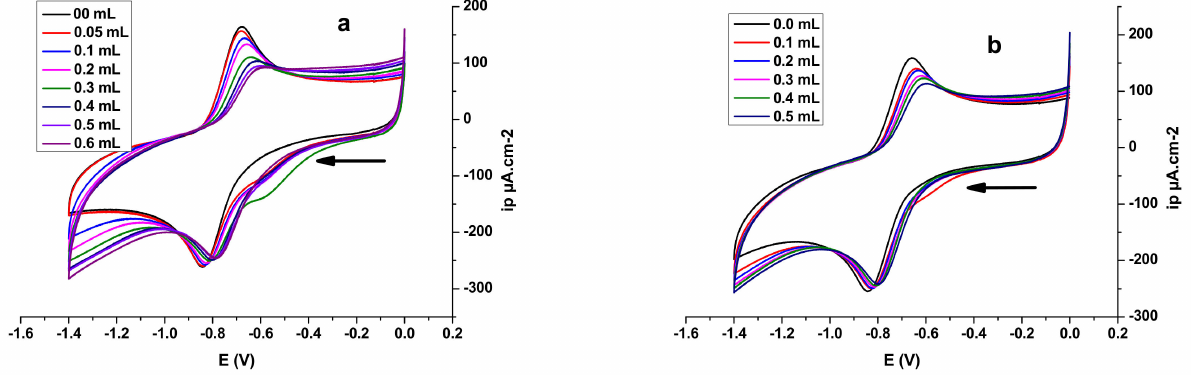
Figure 12. Cyclic voltammograms of oxygen-saturated DMSO/0.1 M Bu 4 NBF 4 on a Pt electrode in the absence and presence of varying concentrations of algal polysaccharidic extracts at a scan rate 100 mV/s: ( a ) E 2 ; ( b ) E 3